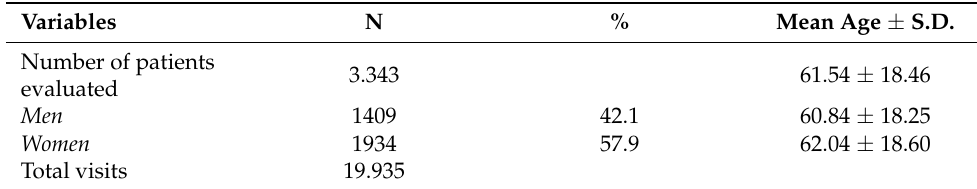
Table 1. Number of patients and visits